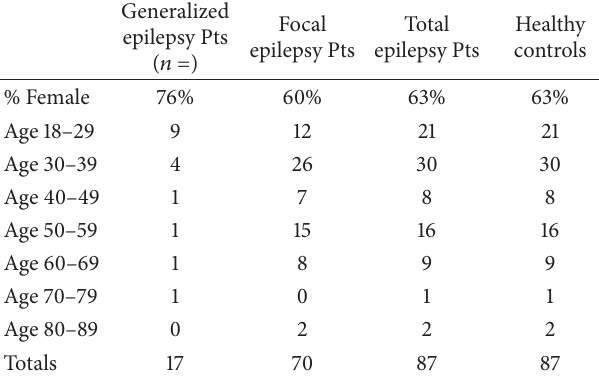
Table 1: Distribution of epilepsy patients and health controls by gender and